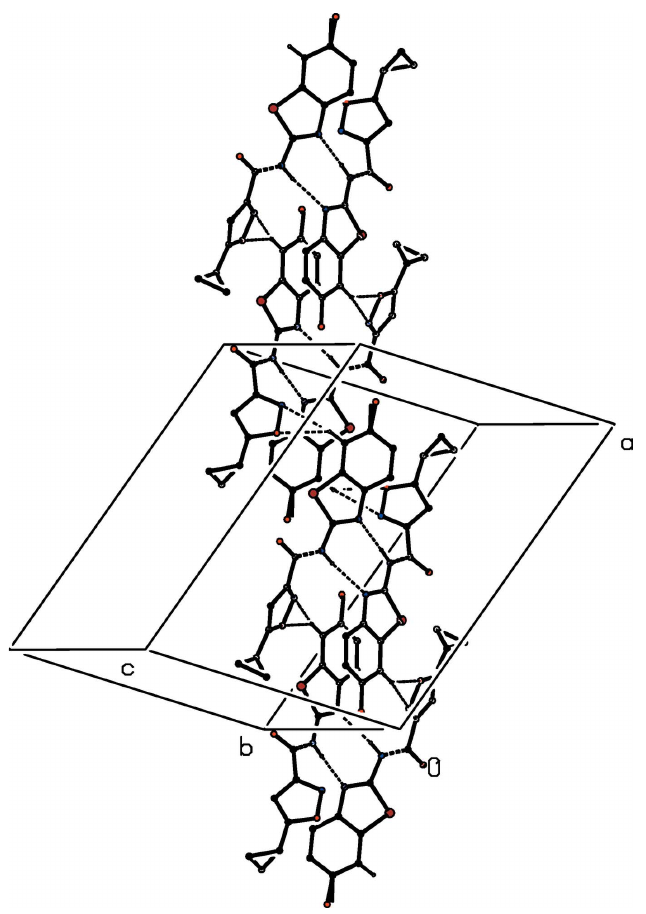
Figure 10 Part of the crystal structure of (III) showing the formation of a chain of rings running parallel to the [101] direction. For the sake of clarity, the methyl groups, the minor disorder component and the H atoms which are not involved in the motif shown have all been